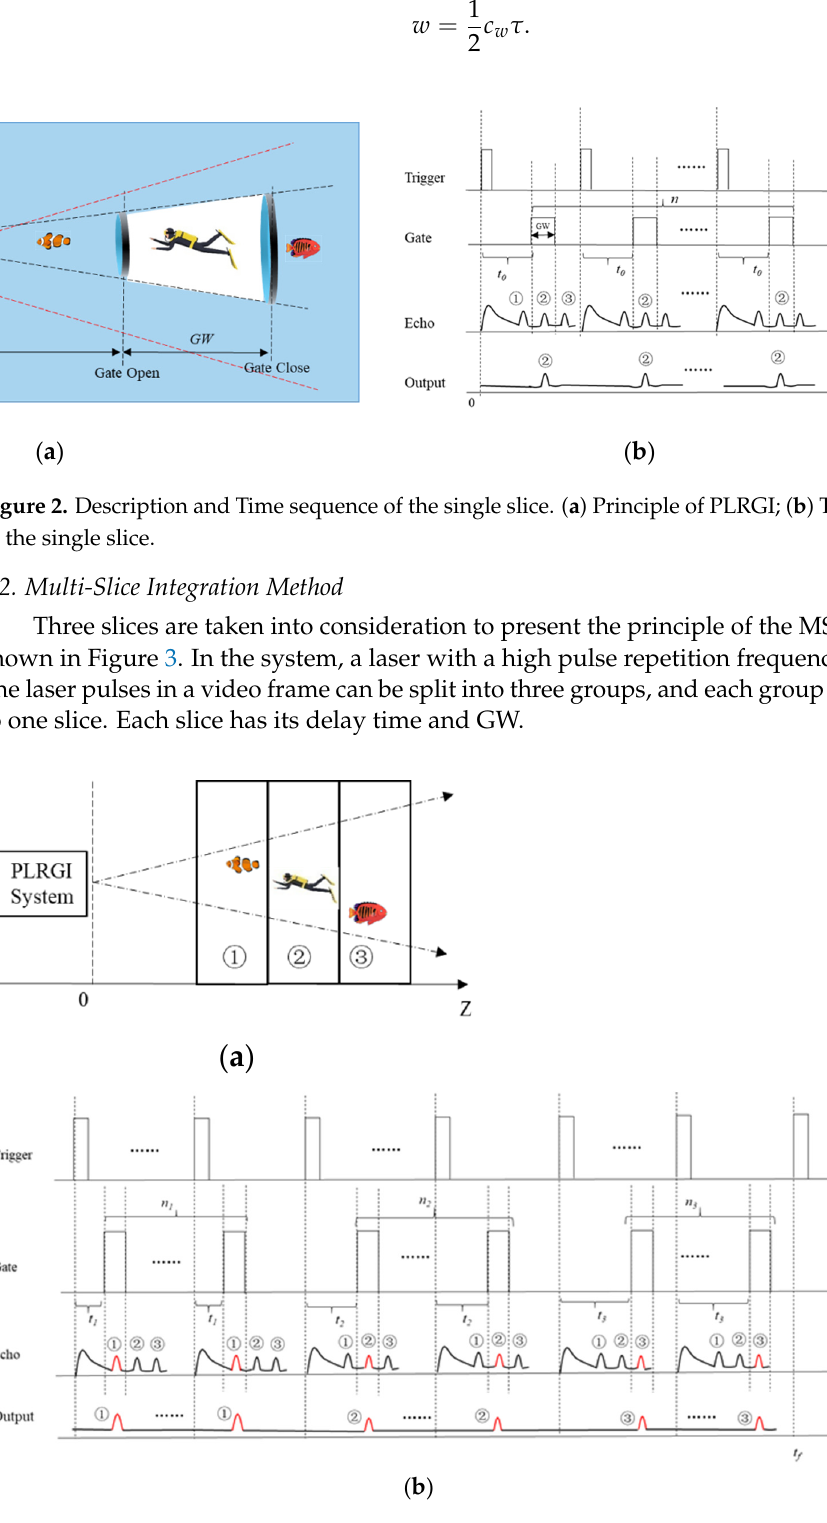
Figure 3. Description and Time sequence of the MSI method with three slices. ( a ) The three targets are in three adjacent slices respectively; ( b ) Time sequence of the MSI method. The same delay time belongs to the same slice, and the slice width is small and only one target echo can be passed. Take the slice which contains target ① as an example to calculate the RIP of a single pulse. The coordinate system established is shown in Figure 4. Here α is the half diver- gence angle of the laser beam. The laser is assumed to emit a pulse of energy E 0 within a short period τ P . Speed of the laser in water is c w . Target is placed at position z away from the imaging system. In this work, multiple scattering and the influence of ambient light are not considered. Figure 4. Coordinate system of PLRGI system. Light intensity within the divergence angle is assumed to be uniformly distributed, then the illumination on the target is: